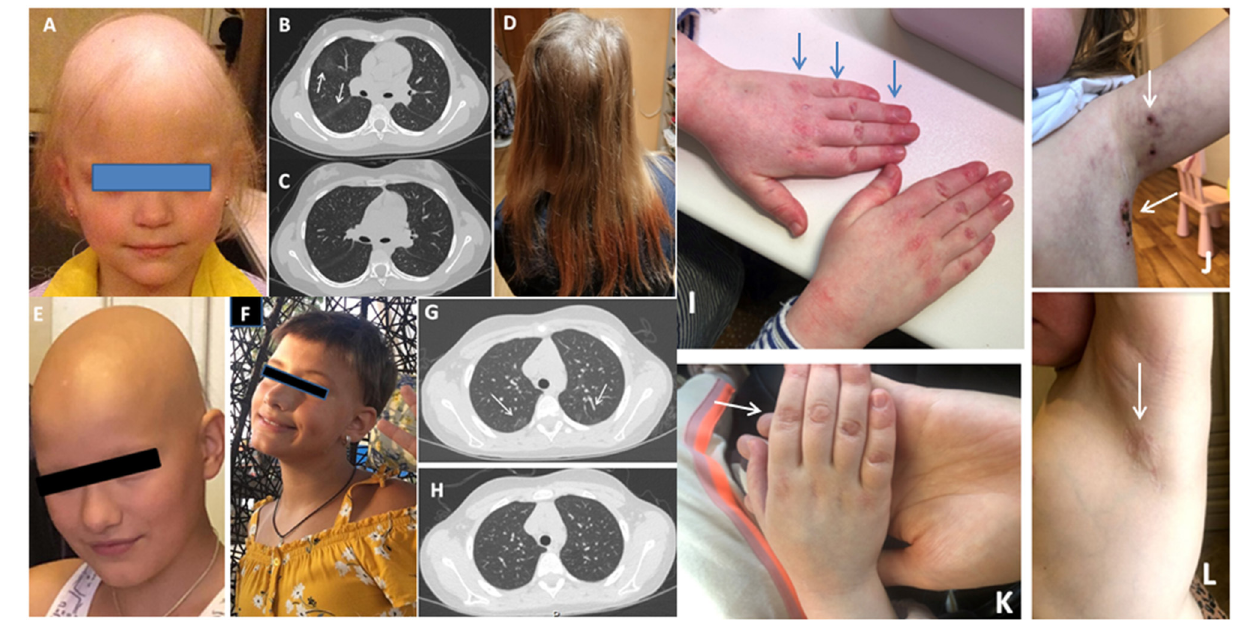
No variants in interferon-pathway related genes were